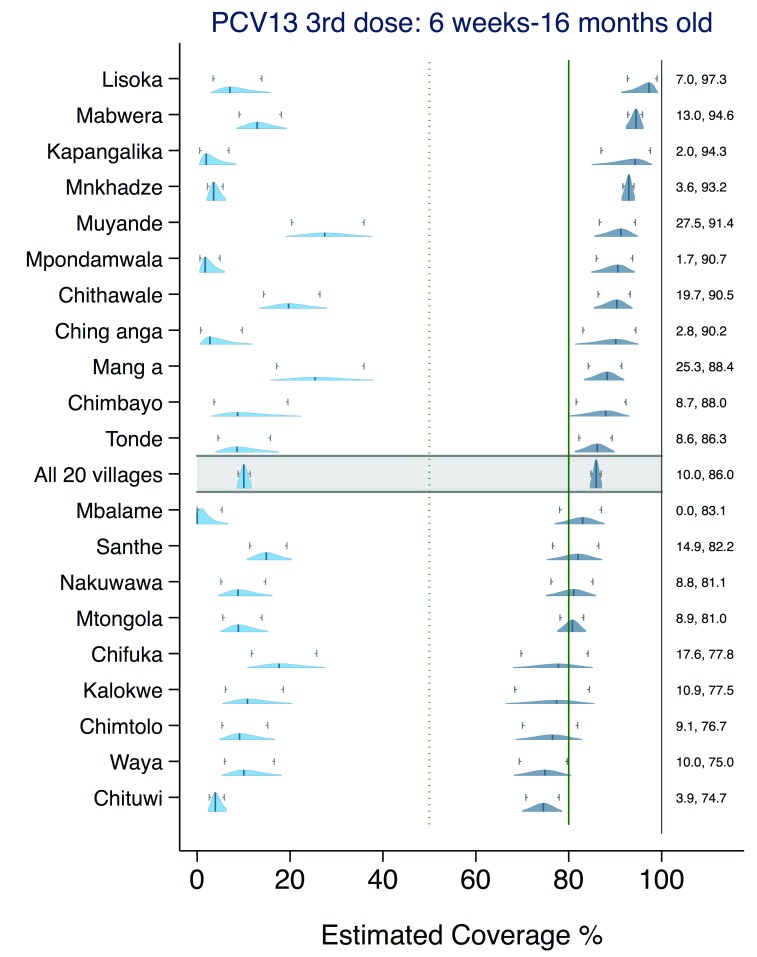
The three-dose coverage of 13-valent pneumococcal conjugate vaccine by lot and survey.Light blue, wave 1 (March 2012); dark blue, wave 6 (June 2014). Numbers on the right indicate the estimated coverage at waves 1 and 6. Tick marks indicate one-sided 95% confidence interval bounds. Green vertical target lines at 50% (dashed) and 80% (solid).